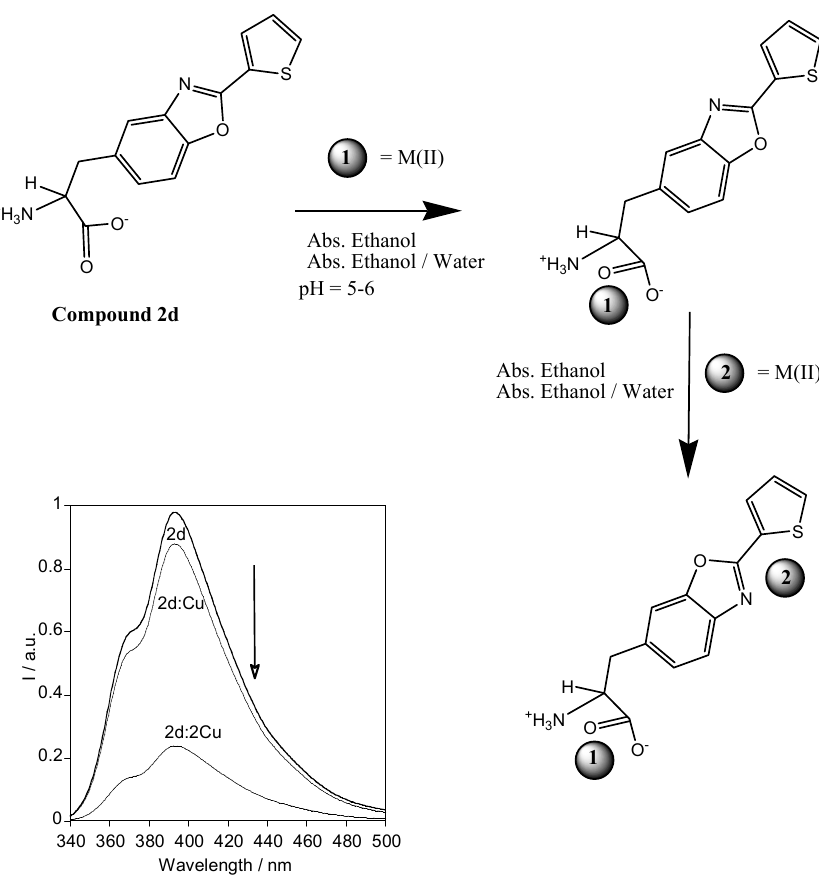
Scheme 2. Schematic representation of the complexation mechanism proposed for alanine 2d upon complexation with Cu(II), Ni(II) and Hg(II). Fluorescence spectra of 2d in the presence of one and